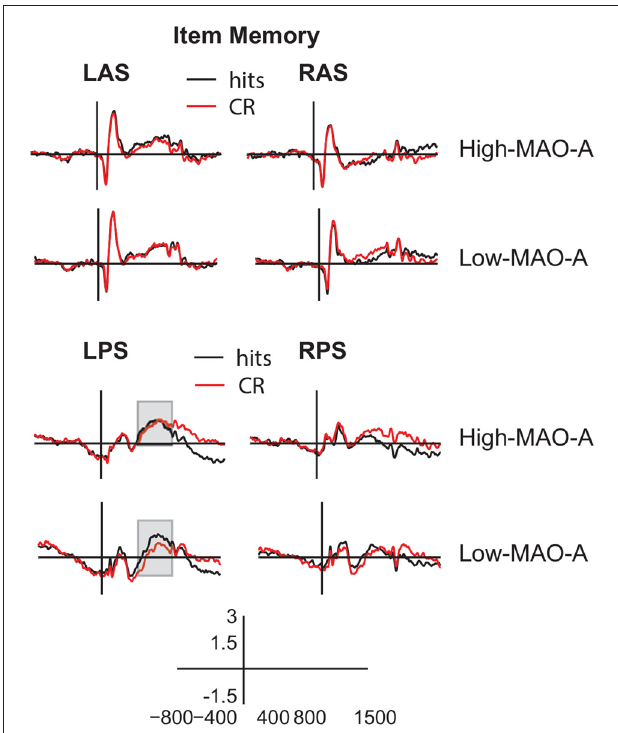
FIGURE 5 | ERP waveforms during item memory retrieval. Averaged ERP waveforms from − 800 ms to 1500 ms post-stimulus presentation (y axis crosses at 0 ms) in the left anterior superior (LAS, top left panels), (RAS, top right panels), left posterior superior (LPS, bottom left panels), and right posterior superior (RPS, bottom right panels) ROIs for hits (black) and CRs (red) during the item memory task. The gray boxes highlight the 500–800 ms timeframe in LPS where the High MAO-A and Low MAO-A groups showed significant differences in the parietal old/new effect. p < 0.01, partial η 2 = 0.10) with mean hit amplitude being